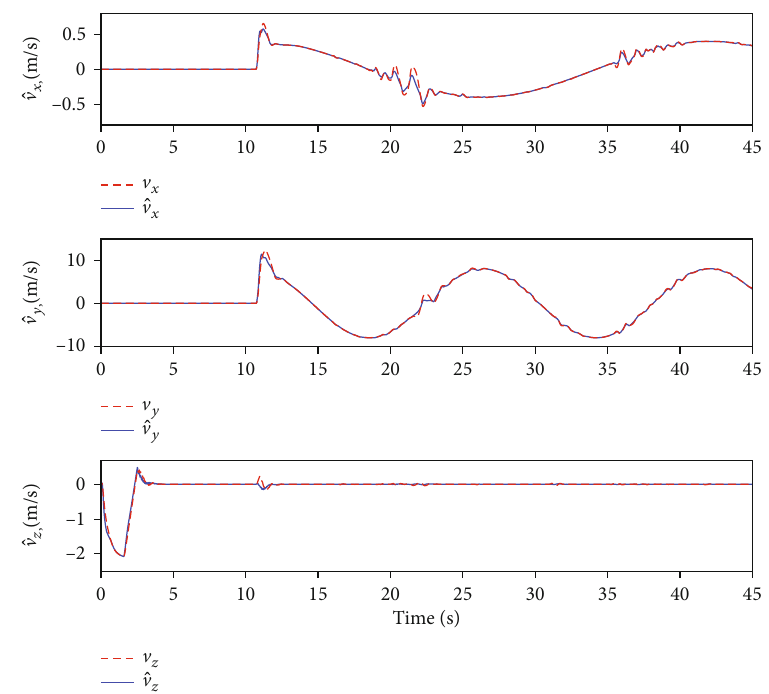
Figure 22: Pro fi les of the estimated velocities of the quadrotor ð ̂ v